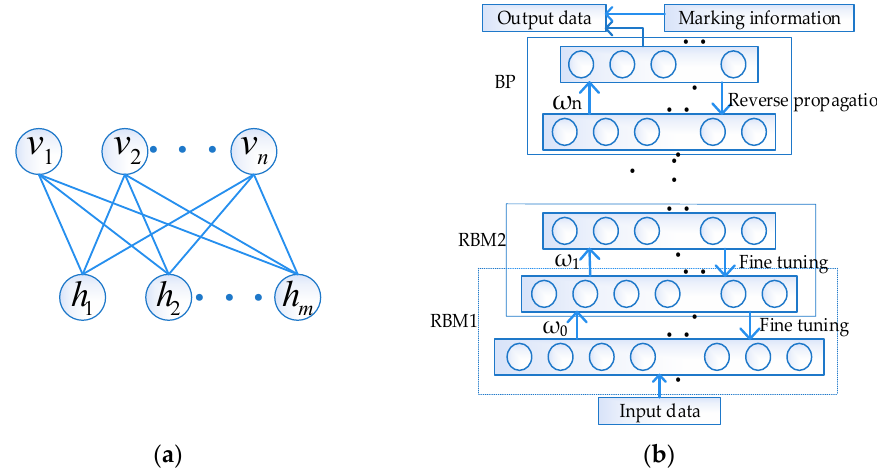
Figure 1. ( a ) Structural diagram of the RBM; ( b ) Structure diagram of